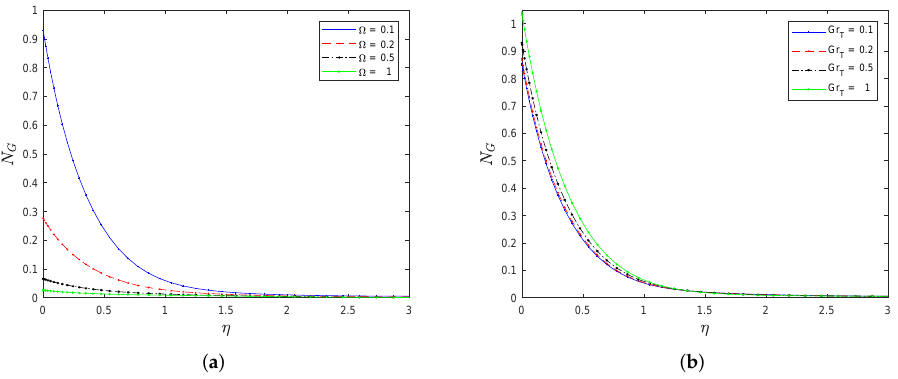
Figure 8. The influences of ( a ) the temperature difference parameter, and ( b ) temperature Grashof number on the entropy generation